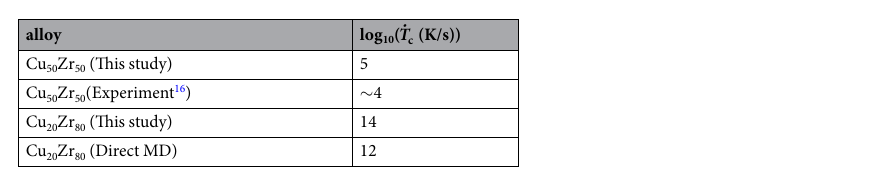
Table 3. Critical cooling rate for a local volume corresponding to Ω = 343 nm 3